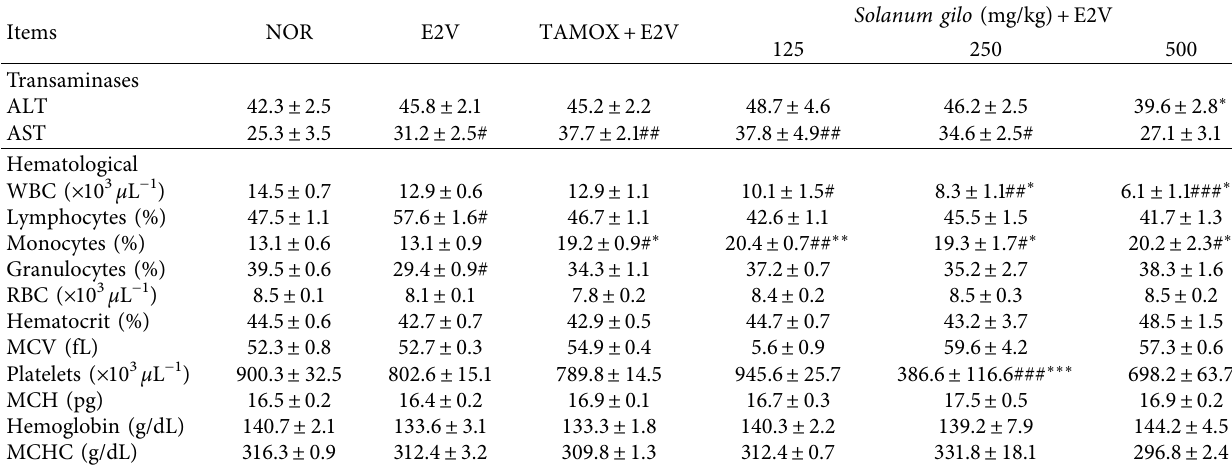
Table 3: Effects of S. gilo hydroethanolic extract on biochemical parameters after 16 weeks of